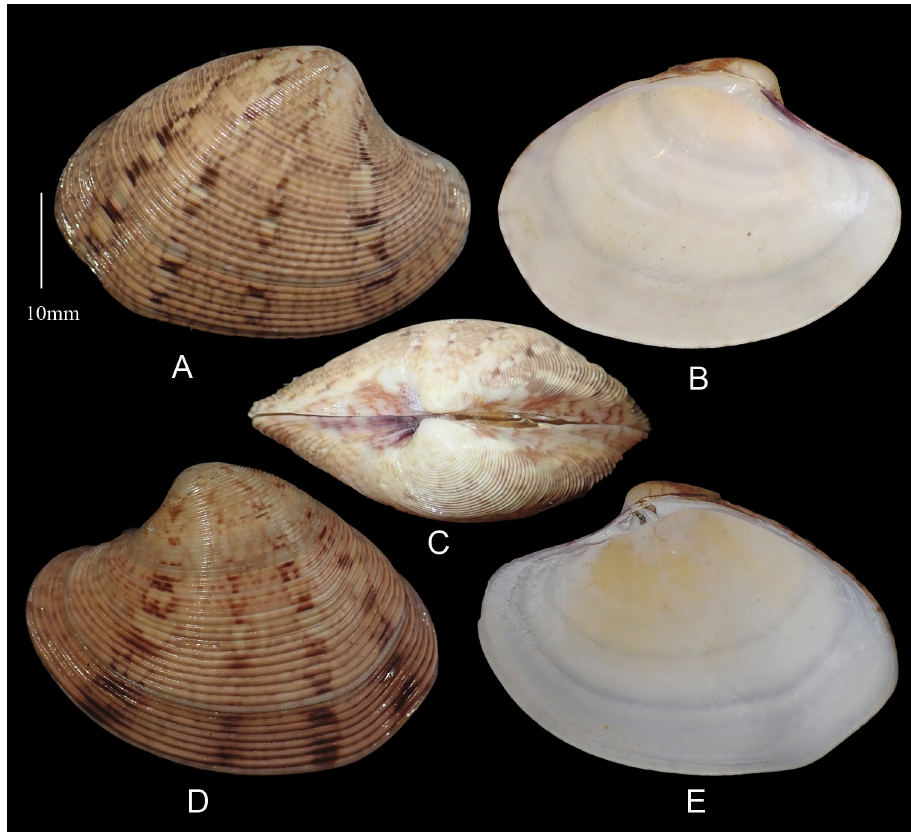
Figure 11. Protapes ziczac A right valve dorsal B right valve ventral C dorsal margin D left valve dorsal E left valve ventral (DABFUK), Kollam, Kerala, South west coast of